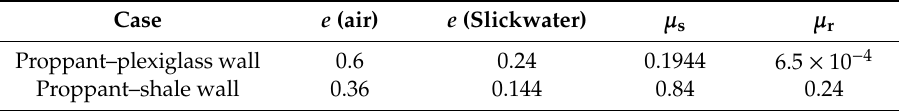
Table 1. Results of the interaction parameters between the proppant and wall. Case e (air) µ s µ r Case Proppant–plexiglass